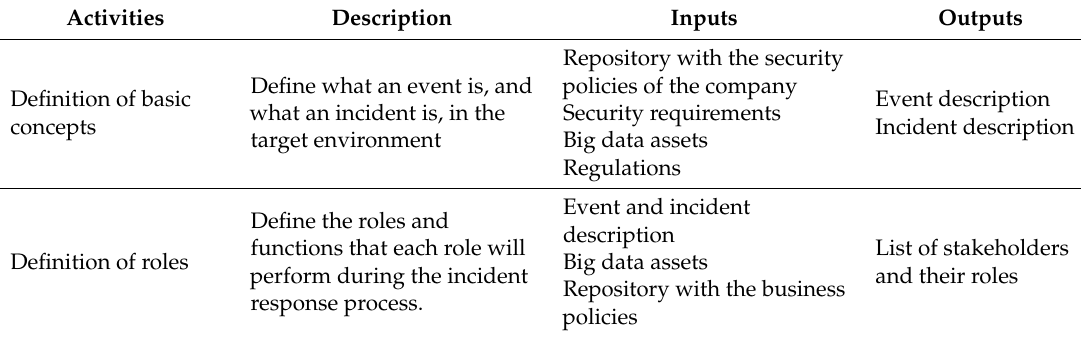
Table 3. Activities of Phase 1: preliminary